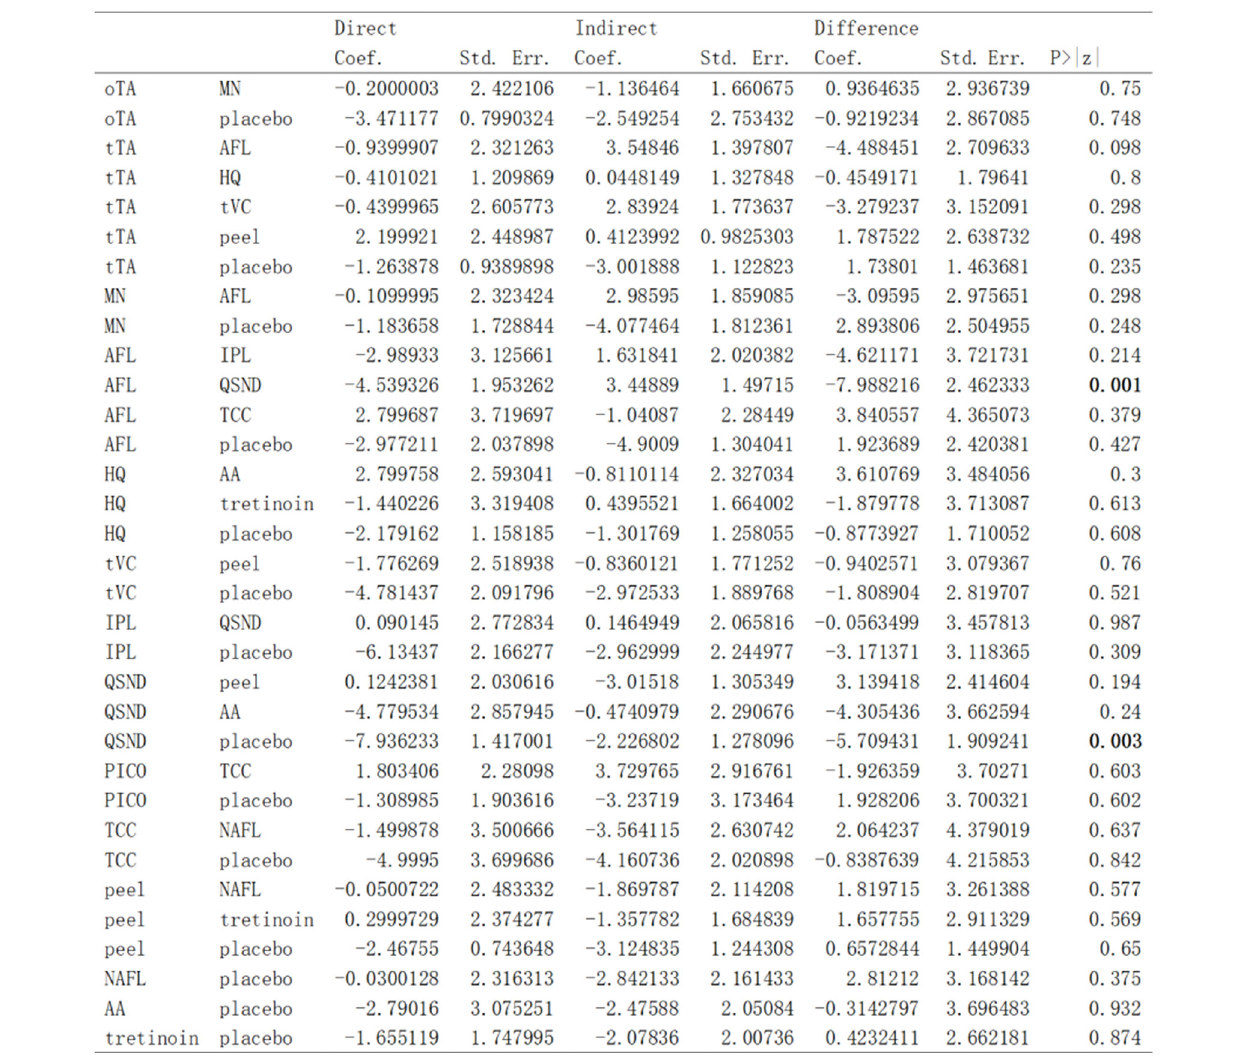
FIGURE 7 | Results from the node-splitting analysis of consistency/inconsistency